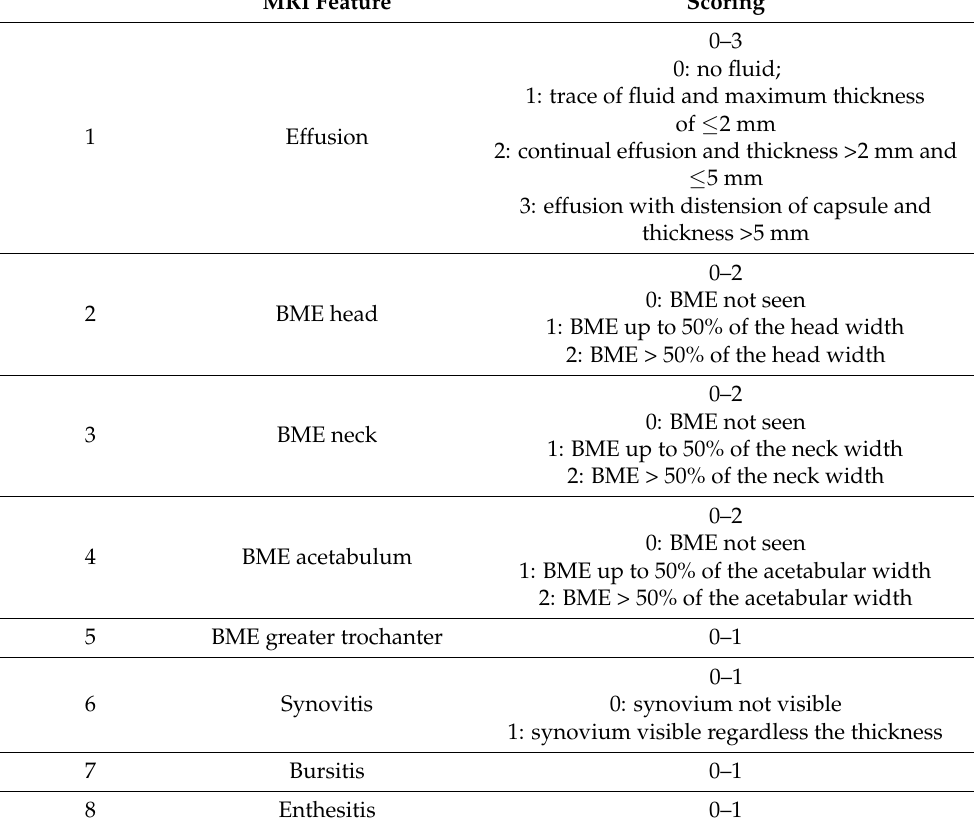
Table 1. MRI scoring